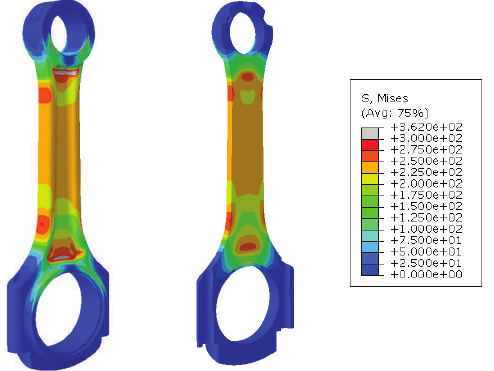
Fig. 14. Results of simulation of connecting rod model